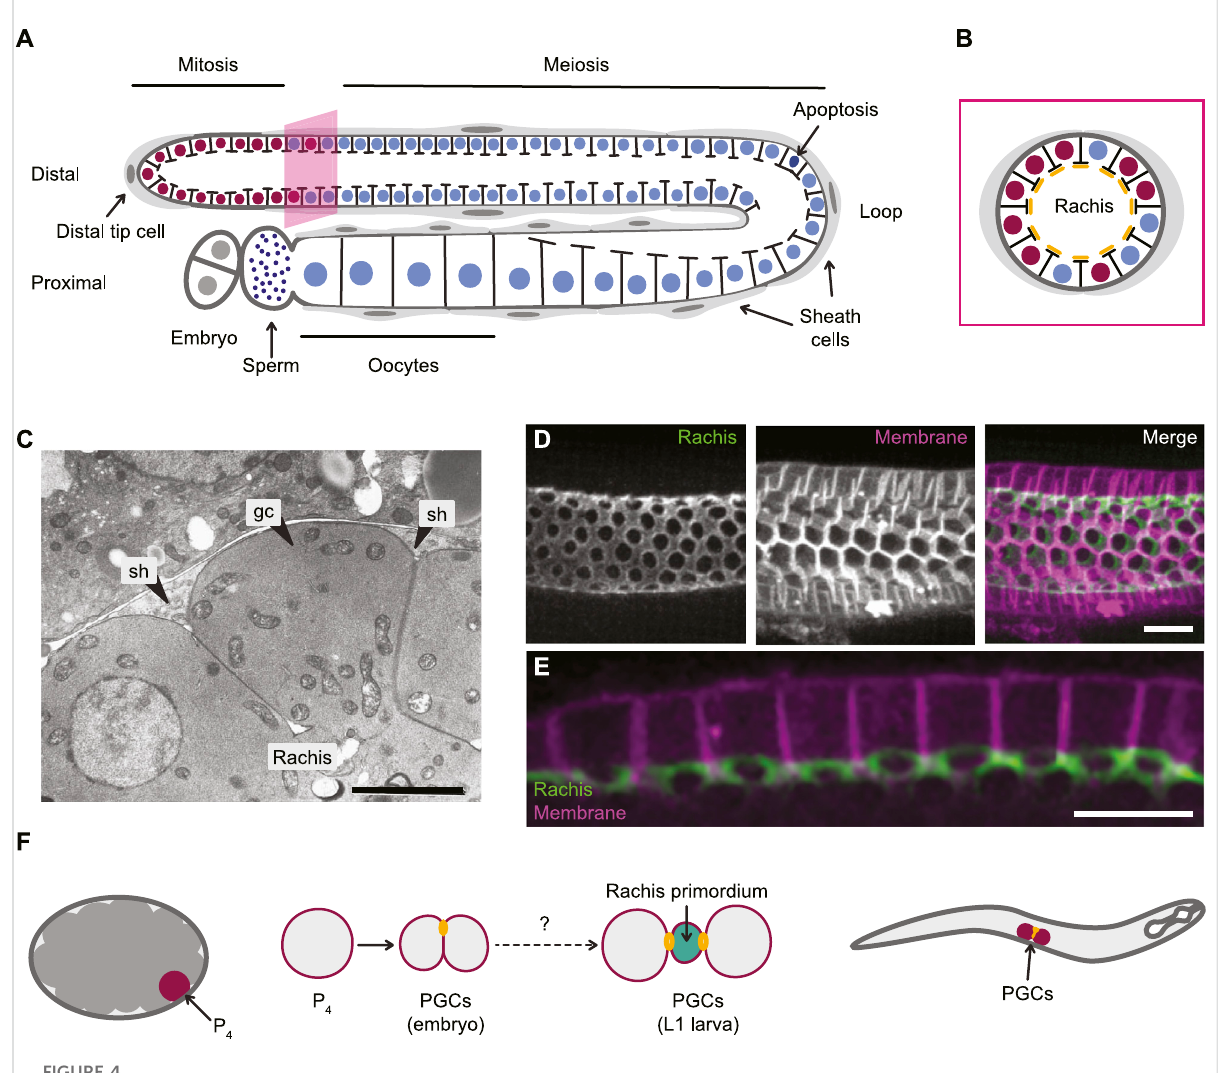
spermatheca. (B) Germ cells are arranged in a rough monolayer around a common core of cytoplasm called the rachis. Each germ cell maintains a stable rachis bridge connecting it to therachis. (C) An electron micrograph of across sectionthrough thegonad showinga germ cells (gc) with an open rachis bridge. Somatic sheath cells (sh)contact germ cells basally. Scale bar is5 μ m.Adaptedwith permission from Hall etal., 1999, Elsevier. (D) A maximum intensity projection of ~half of the adult gonad tube, showing the rachis surface (green; marked by ANI-2:GFP) and cell membranes (magenta; marked by mCherry:PH PLC δ ). (E) A longitudinal section of the adult gonad showing the rachis bridges (green; marked by ANI-2:GFP) connecting each germ cellto therachis.Cell membranesare inmagenta. (D) and (E) areadaptedfrom Pritietal.,2018,CC-BY.Scalebars are10 μ m. (F) All germ cells are derived from the P 4 germline precursor cell that gives rise to the two primordial germ cells (PGCs) during embryogenesis. P 4 undergoes incomplete cytokinesis and the two embryonic PGCs remain connected by a stable intercellular bridge. By an unknown mechanism,